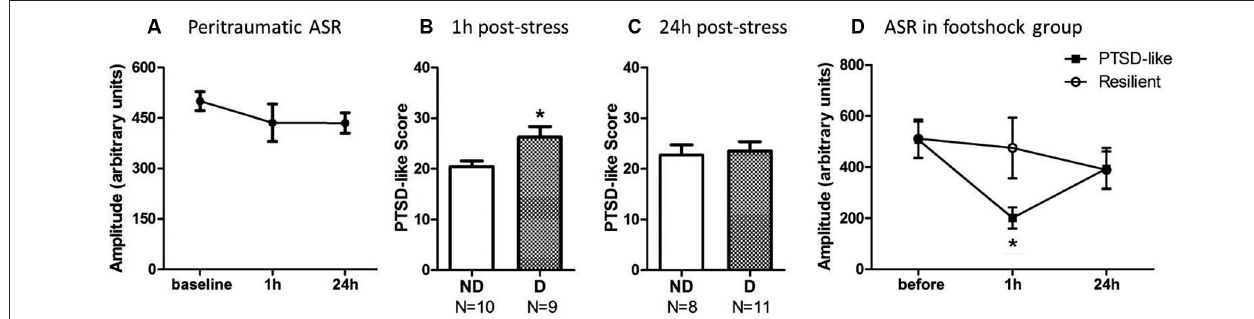
FIGURE 3 | Animals with ASR attenuation at 1 h after stress were more likely to develop severe PTSD-like behaviors 2 weeks later. (A) The footshocked rats showed a trend on attenuation of ASR amplitude. (B) PTSD-like score of animals in ASR declined (D) or not-declined group (ND) according to decline ratio at 1 h after stress. (C) PTSD-like score of animals in ASR declined or not declined group according to decline ratio at 24 h after stress. (D) ASR at different time points around stress of PTSD-like and resilient individuals. * p < 0.05.